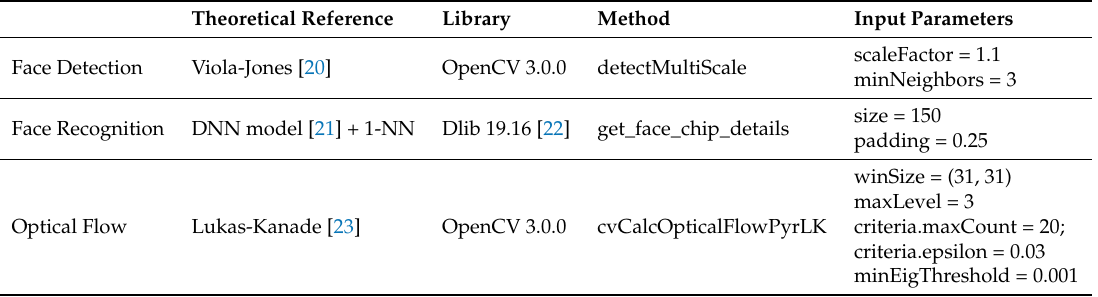
Table 1. Technical information regarding the implemented CV application. Only non-default parameter values are